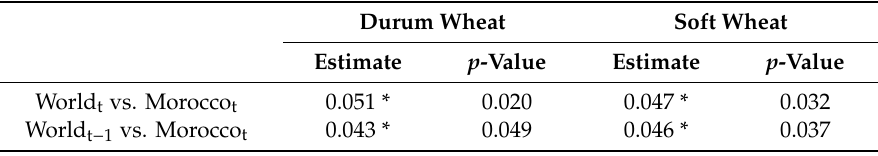
Table 5. Kendall’s tau coe ffi cients.